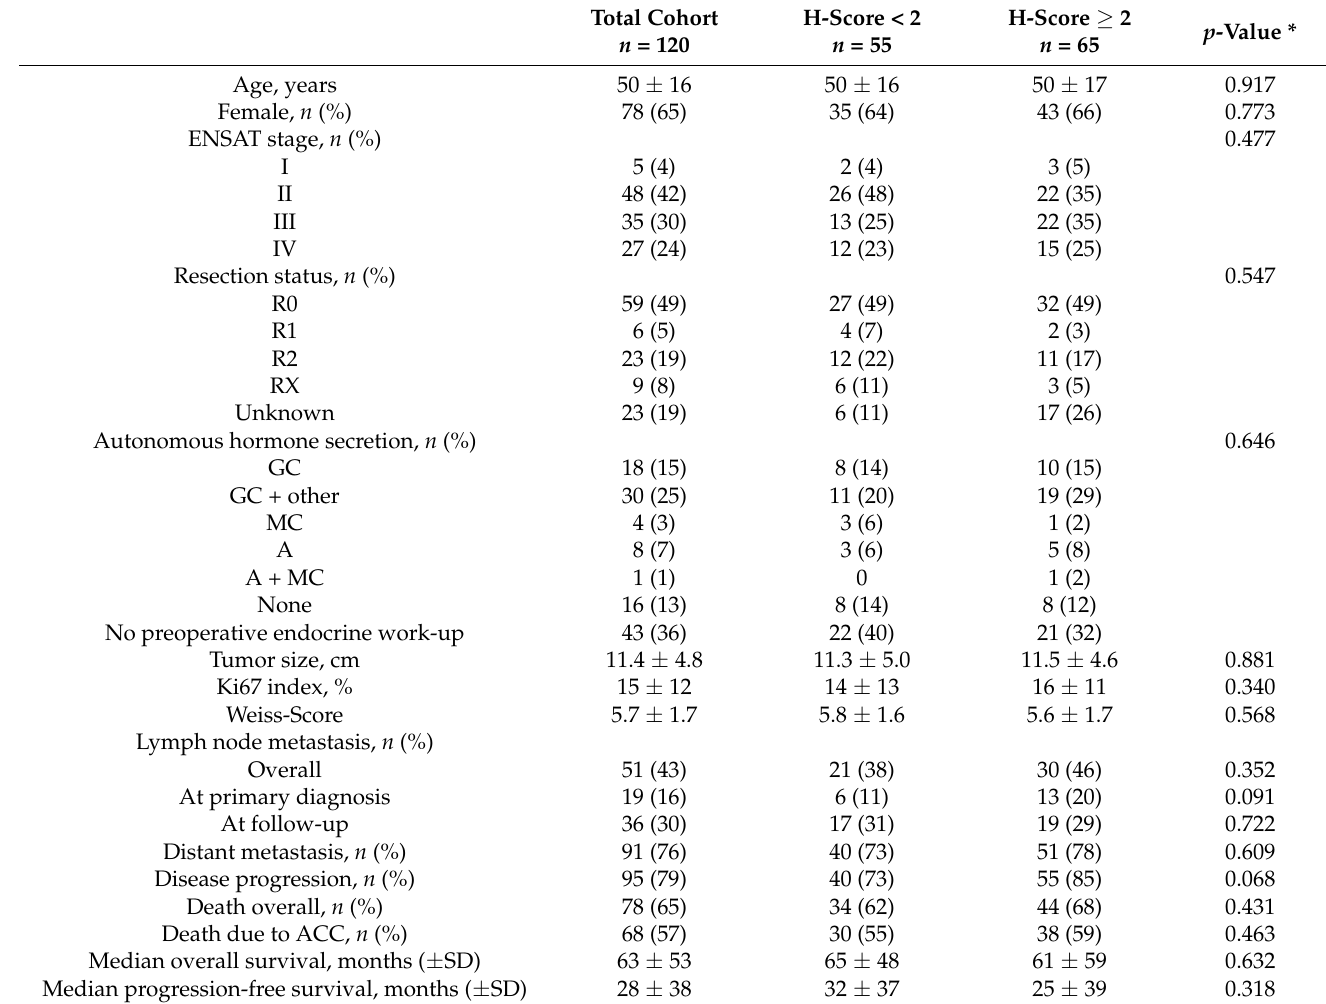
Table 1. Characteristics of the ACC patients with analyzed primary tumors reported in this